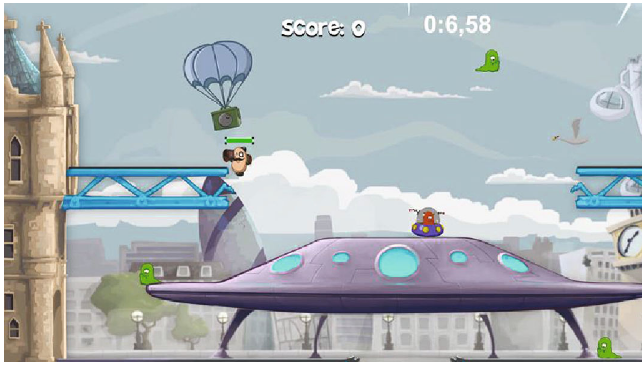
Figure 3: The screenshot shows a 2D shooter computer game platform.